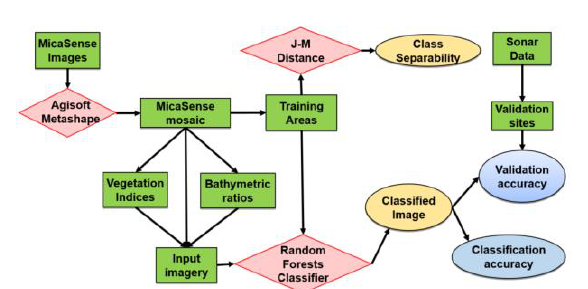
Figure 4. Flowchart presenting the methodology used for producing and validating all classified images.